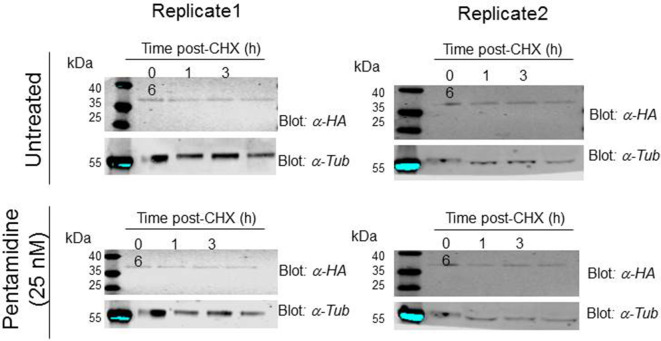
Western blots for a 3xHAAQP2 turnover assay in untreated T. brucei 2T1 cells, or in the presence of pentamidine 25 nM.Two independent experiments are shown. HA, haemagglutinin; tub, β-tubulin; CHX, cycloheximide; α-HA, anti-HA serum. All data for these graphs are contained in Figure 6—source data 1.